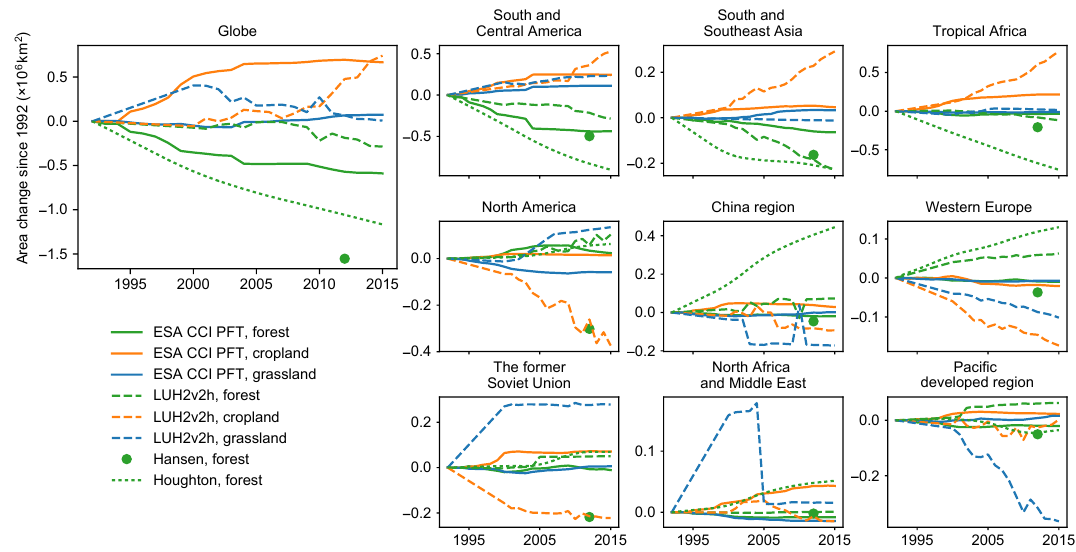
Figure 4. Global and regional net area changes in forest, cropland and grassland PFTs derived from ESA CCI land cover maps since 1992. Data from LUH2v2h (Hurtt et al., 2011), Hansen et al. (2013) and Houghton and Nassikas (2017) are also shown for comparison. Note that net forest area change from Hansen et al. (2013) is corresponding to the period of 2000–2012, and thus the forest area change between 1992 and 2000 from ESA CCI was added as Hansen et al. (2013) data in the